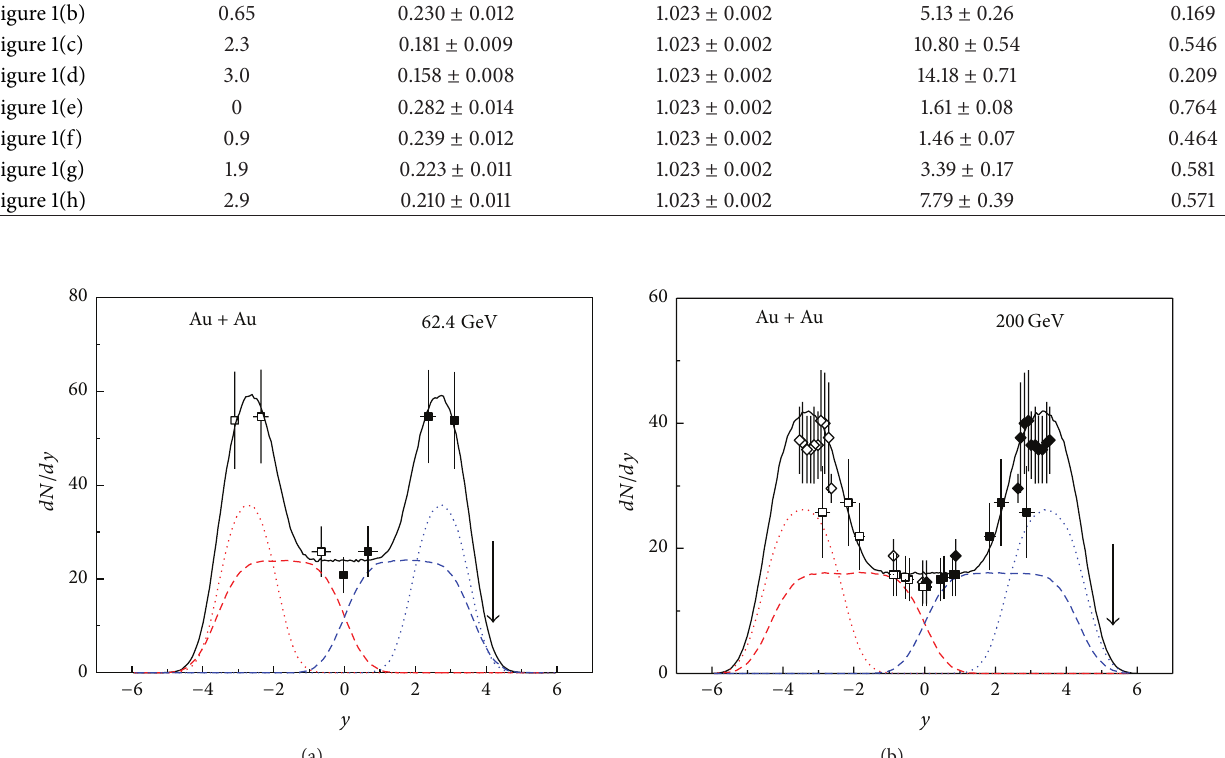
Figure 2: Rapidity distributions of net-baryons in central Au-Au collisions at (a) 62.4 and (b) 200 GeV. The solid symbols represent the experimental data of the BRAHMS Collaboration [17–19] measured at the RHIC and collected together in [20], and the squares and diamonds are for 0–5% and 0–10% centralities, respectively. The open symbols are reflected from the data around midrapidity. The curves are our calculated results, where the dotted and dashed curves from left to right are the contributions of LT, TC, PC, and LP, respectively, and the solid curves are the sum of the four sources. Arrows indicate the beam rapidities. See text on the discussion of a few net-baryons to extend beyond the beam